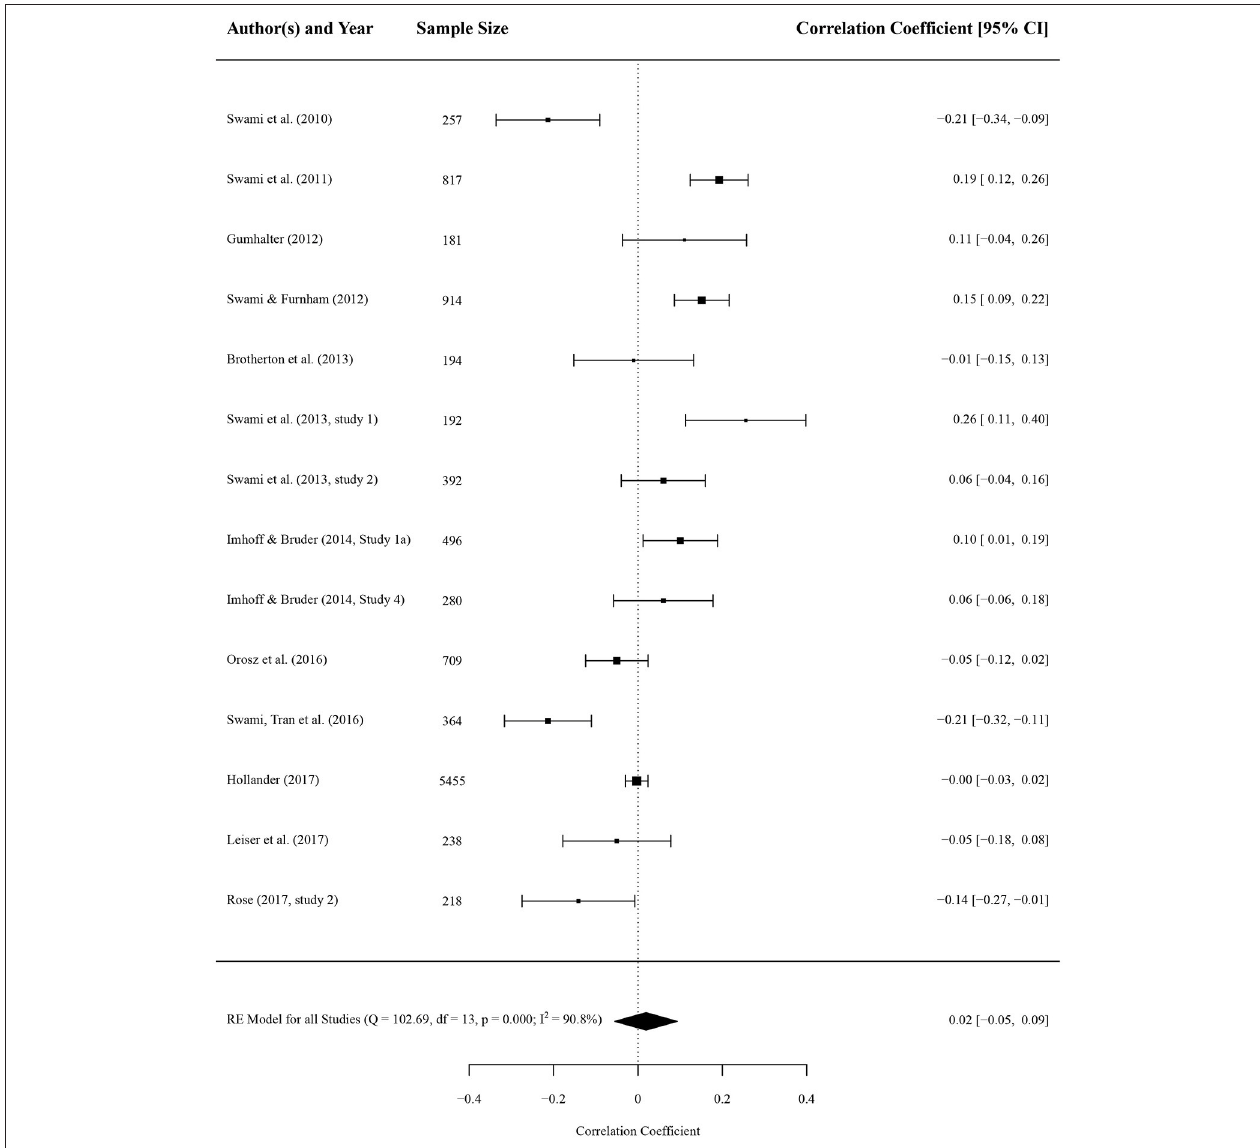
FIGURE 2 | Forest plot of correlation coefficients between conspiracy beliefs and openness to experience. A positive effect size indicates that higher levels of conspiracy beliefs is associated with higher levels of openness to experience. Average effect was calculated using a random-effects model.